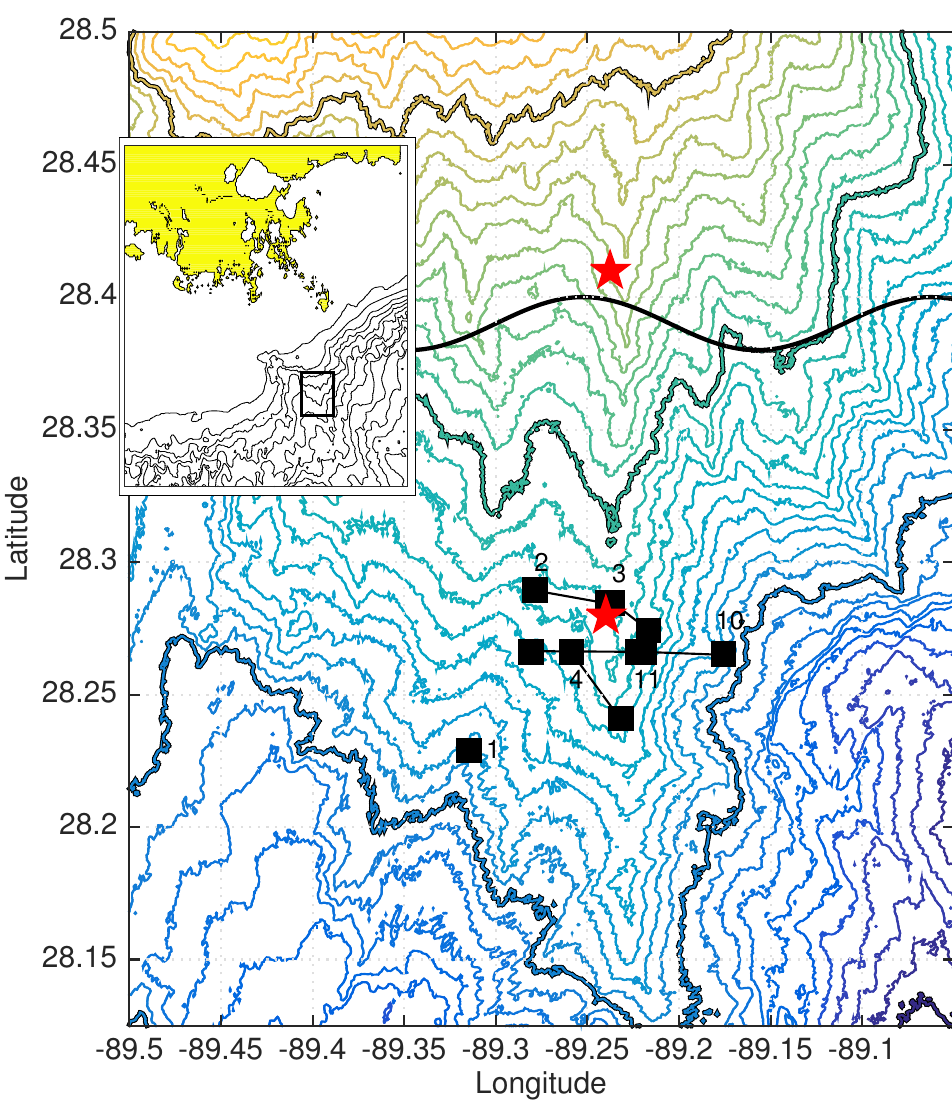
Figure 2. Topography about the deep mooring. Contour intervals are at 25 m with thick lines denoting the 500, 750, and 1000 m isobaths. Mooring locations are depicted with red pentagrams. The locations of CTD casts and tow-yos in the vicinity of the deep mooring are depicted with black squares and connecting lines. Numbers correspond to the initial positions of the respective casts/tow-yos. The inset graphic locates the experimental area on the eastern flank of Mississippi Canyon. The solid black trace at the top depicts the horizontal wavelength λ h = 2 π U / f = 18 km with U = 0.20 m s − 1